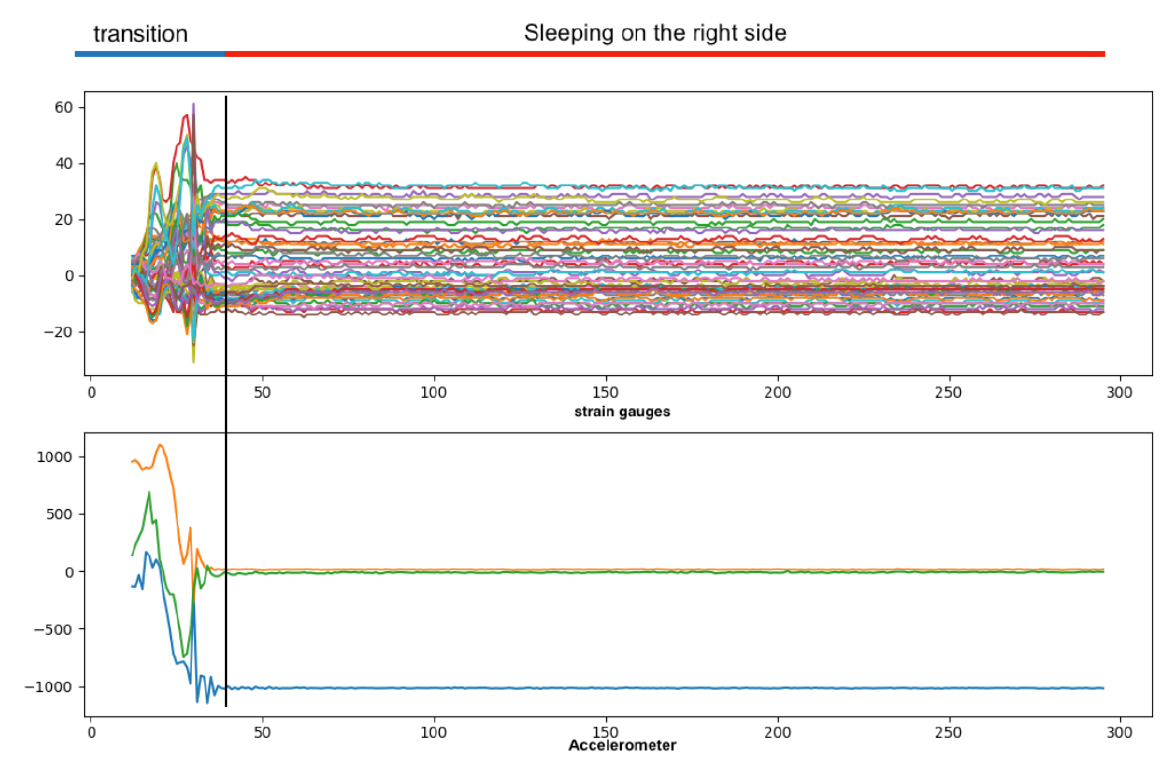
Figure 3. Labeling TS1 and RLD. We have labeled the TS activities based on the time period of previous activity and visual comparison.